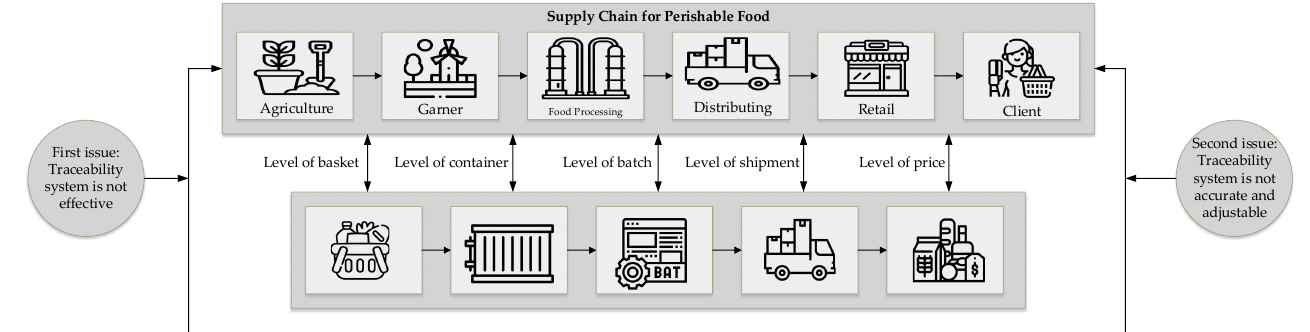
Figure 1. Perishable Food Supply Chain